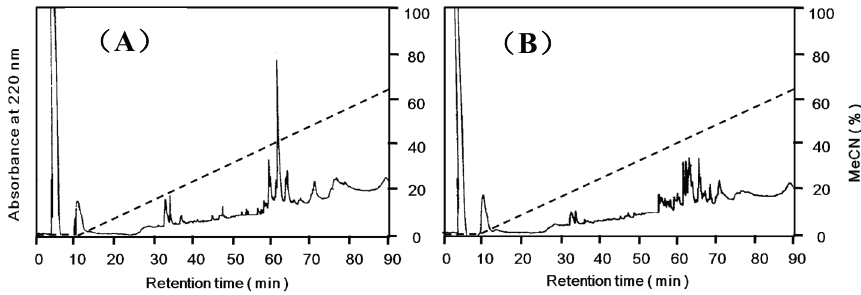
Figure 5. Peptide maps of Apios tuber lectin (ATL) and Fraction A. Each protein was reduced and S -carboxamidomethylated, and digested with arginylendpeptidase. Peptides were separated by reversed-phase HPLC on TSKgel ODS 120T (5 μ m, 4.6 × 250 mm) using a linear gradient of acetonitrile in 0.1% trifluoroacetic acid at a flow rate of 1.0 mL/min. ( A ) ATL; ( B ) Fraction